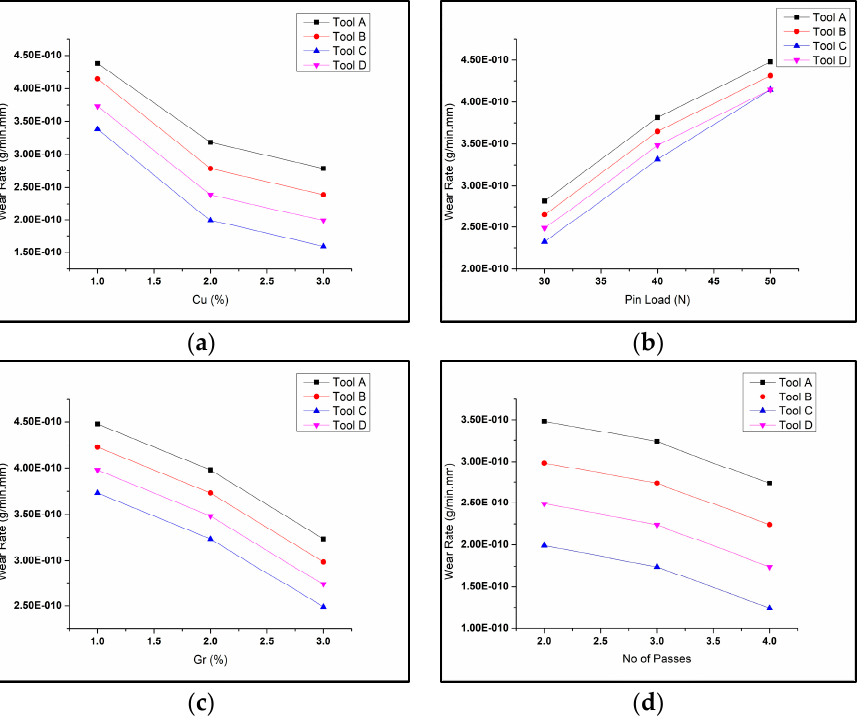
Figure 3. ( a ) WR vs. copper weight% at 500 rpm, 30 N; ( b ) wear rate (WR) vs. pin load at 2% copper, 600 rpm; ( c ) WR rate vs. graphene weight% at 400 rpm, 50 N; ( d ) WR vs. number of passes at 400 rpm, 30 N, for Tools A, B, C, D.